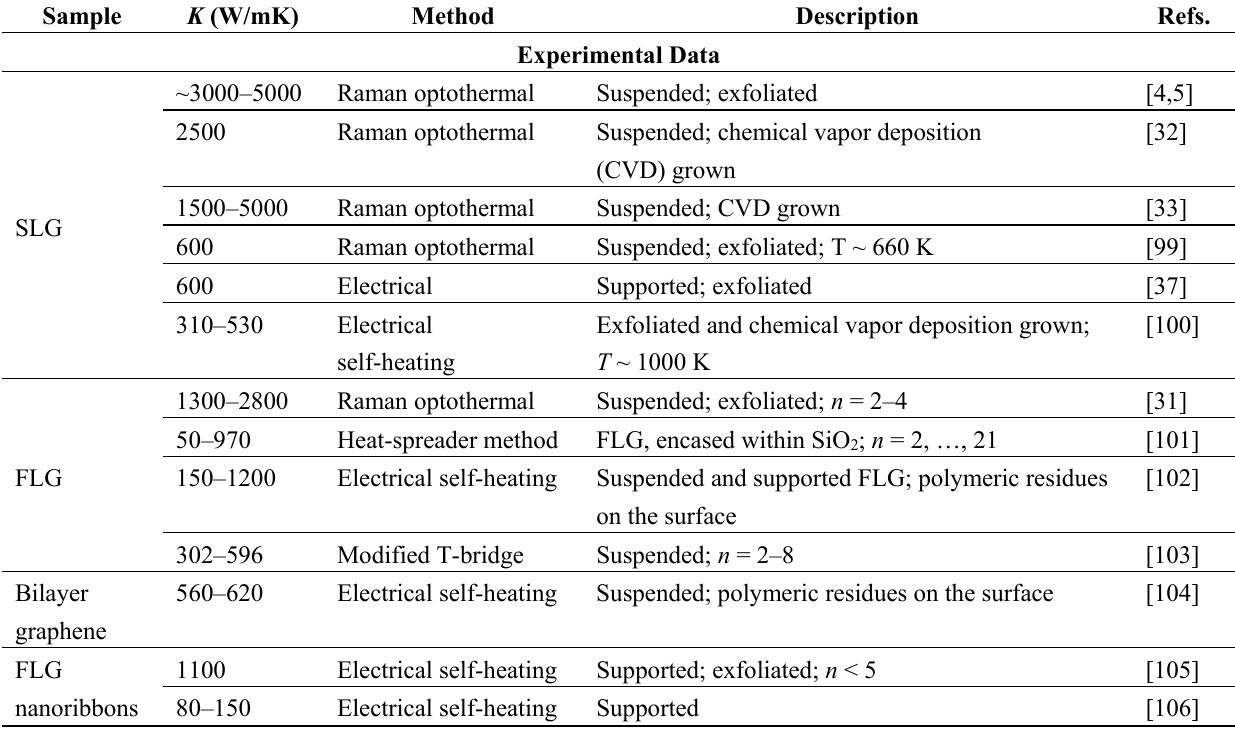
Table 1. Thermal conductivity of graphene and graphene